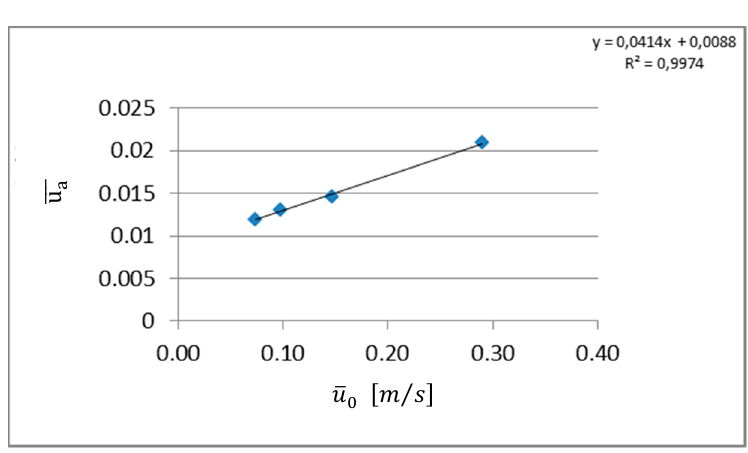
Figure 7. Analysis of the variation in the average velocity of the flow across the opening with jet velocity.